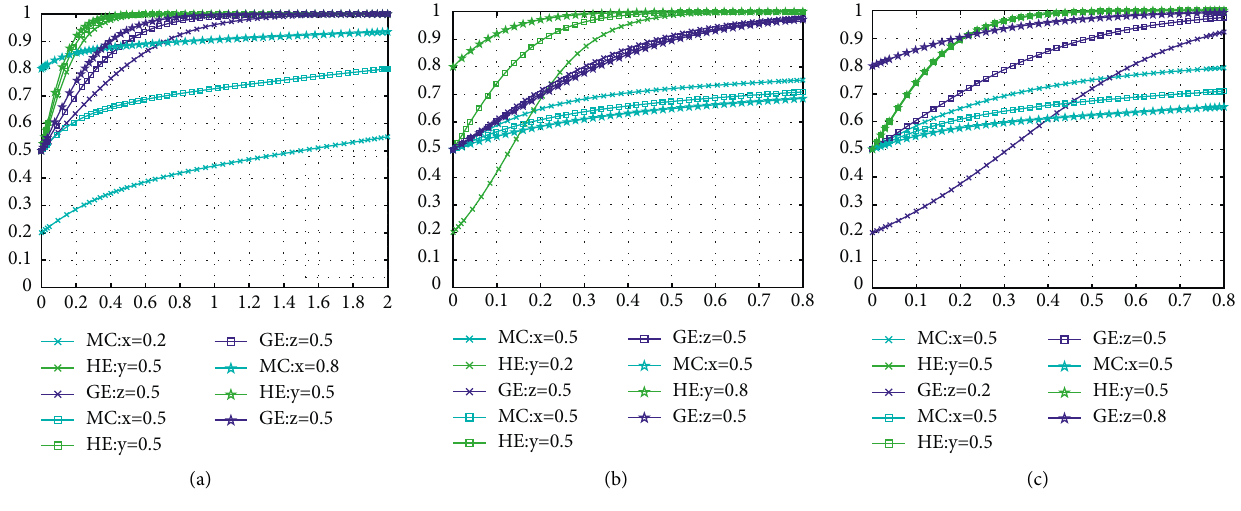
Figure 2: The evolutionary result of changes in participation willingness x (a), y (b), and z (c).